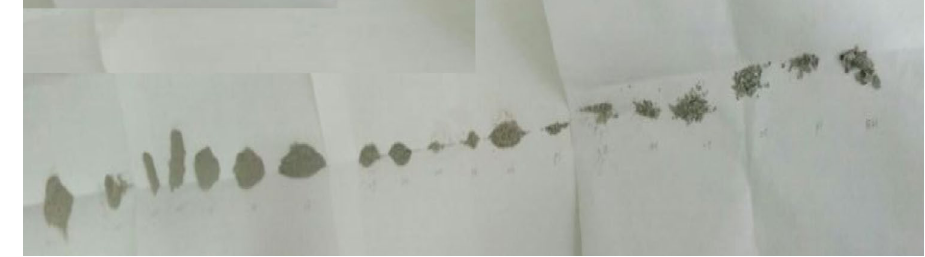
Fig. 3 A picture of screening cuttings